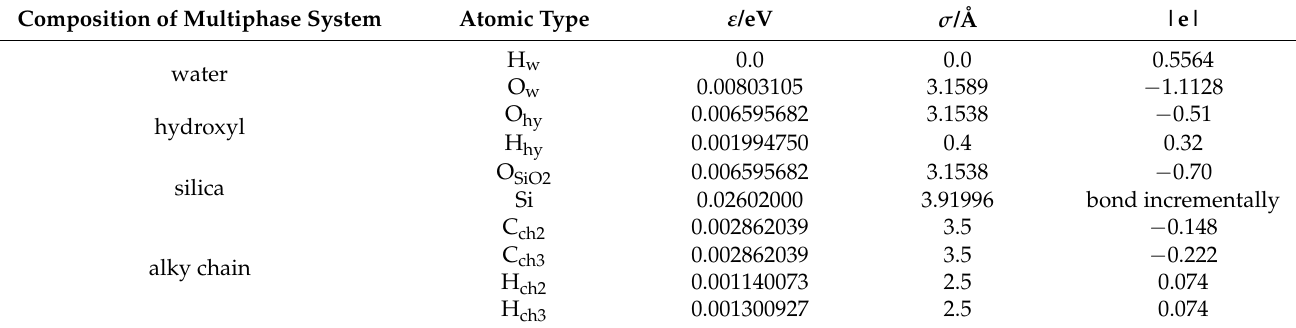
Table 1. The LJ potential energy parameters and coulombic charge in the model [12]. Composition of Multiphase